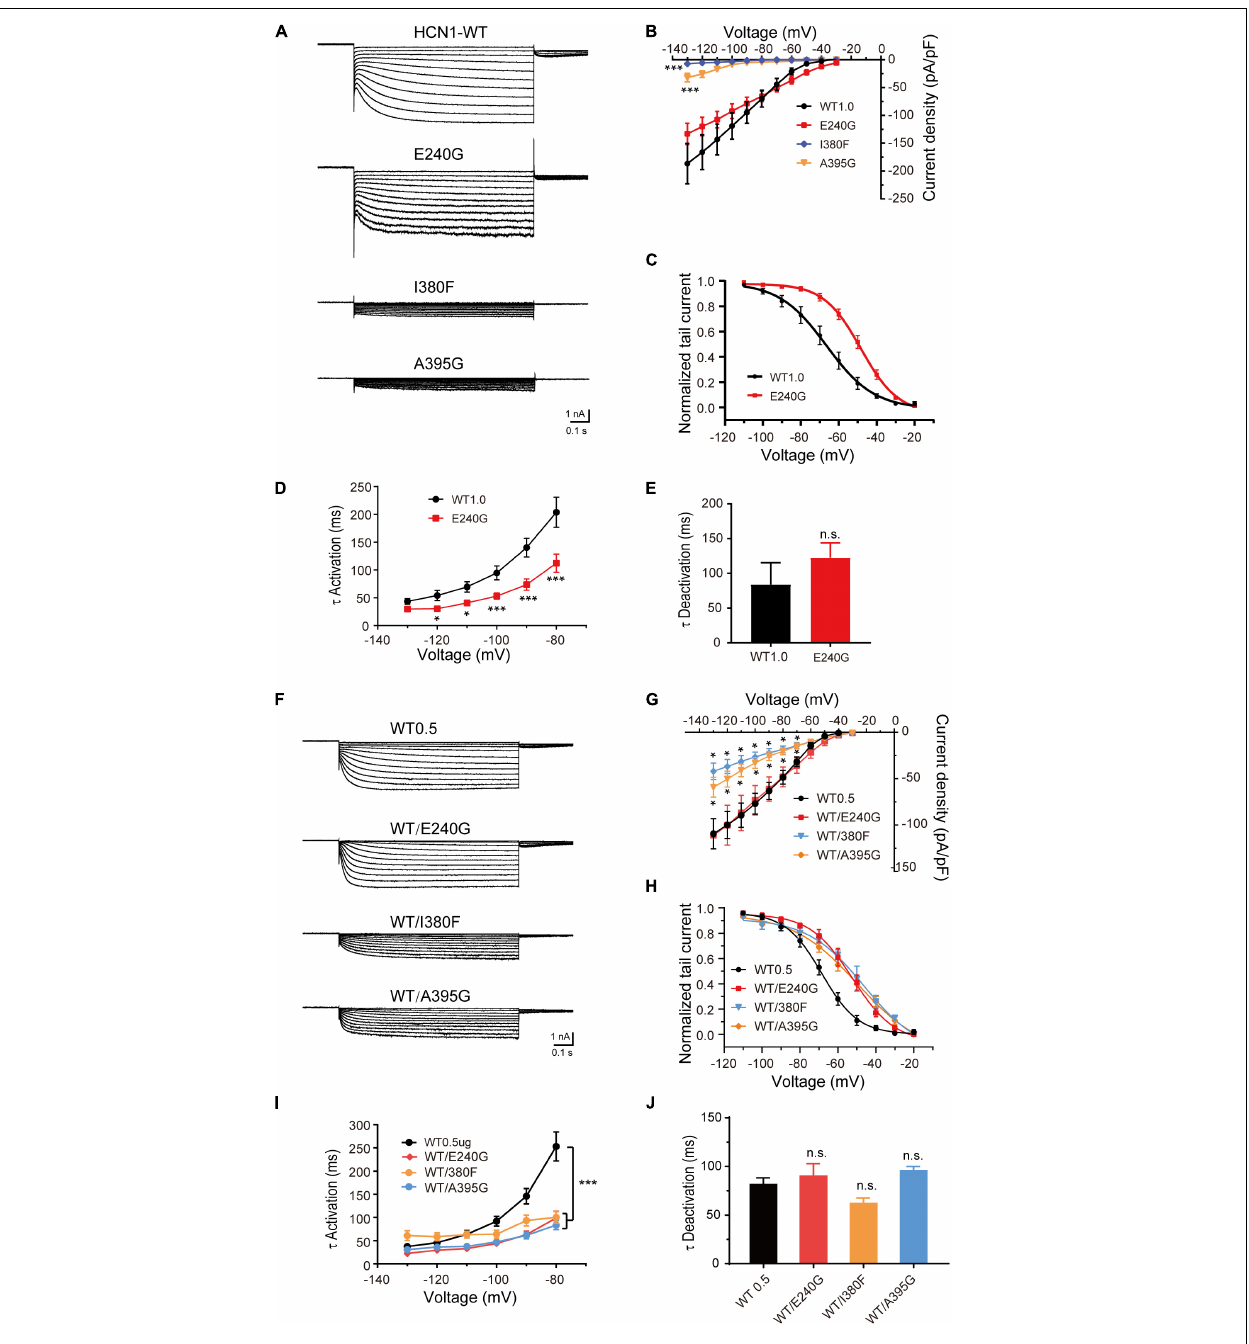
Frontiers in Molecular Neuroscience |